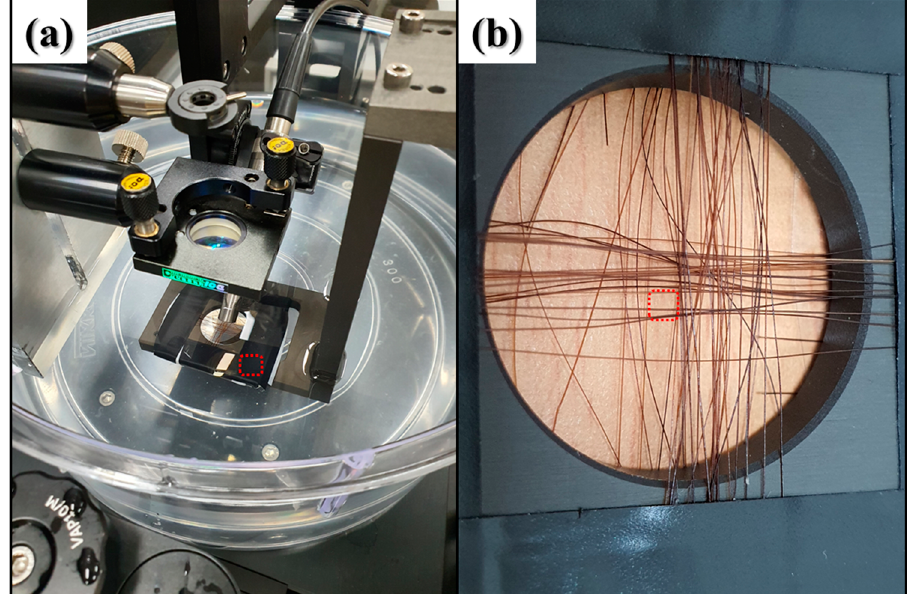
Figure 7. Experimental setup for PA imaging: ( a ) experimental setup; ( b ) sample target used.